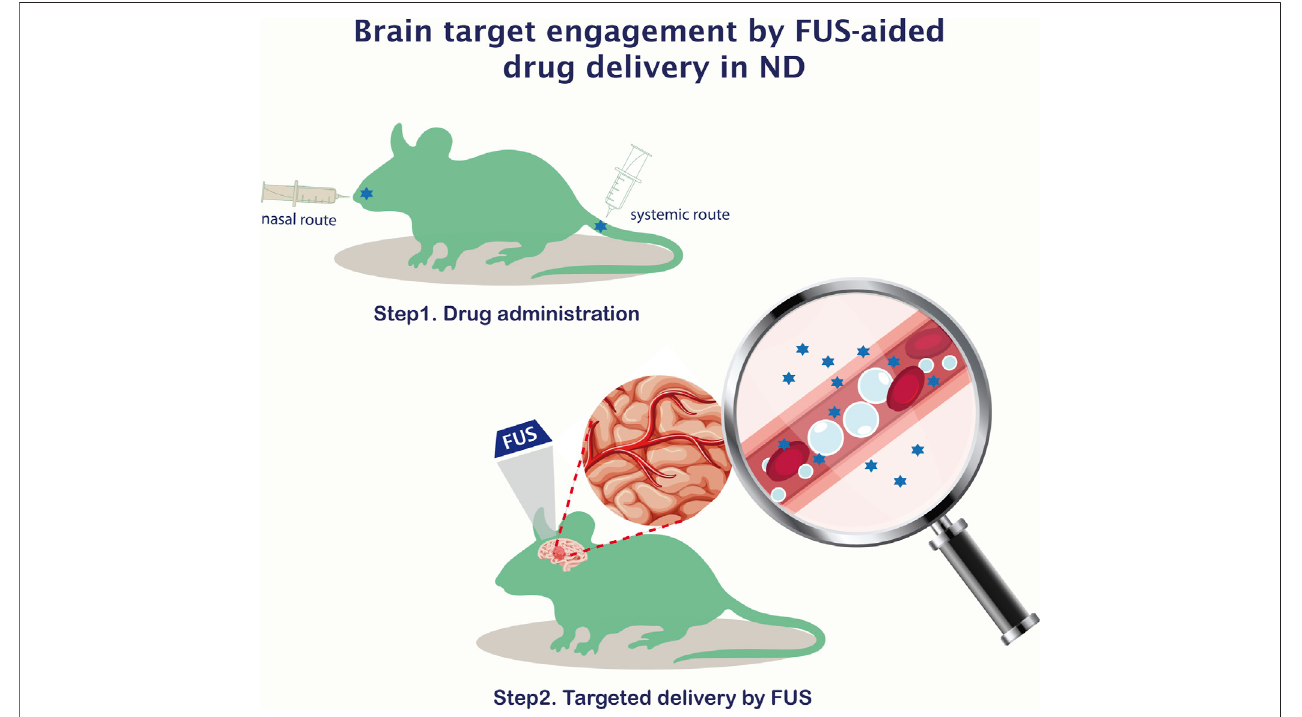
FIGURE 2 | Brain target engagement by FUS-aided delivery of drugs in NDs therapy. A two steps experimental paradigm with the intranasal or systemic administration of the drug of choice, followed by FUS-driven local brain stimulation allowing non-invasive, targeted, and transient opening of the BBB at the region of interest for therapeutic